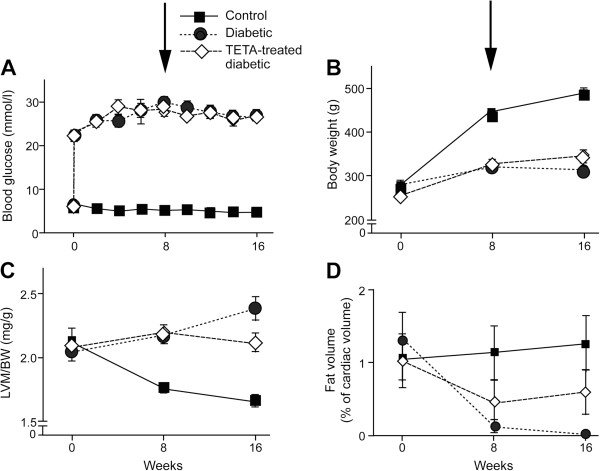
Time- and treatment-dependent changes in blood glucose concentrations, body-weight, and indexes of LV size and composition during the 16-week experimental period in groups of control (n = 12), untreated-diabetic (n = 12) and trientine-treated diabetic (n = 13) adult male rats. Drug treatment was initiated after the measurements of Week 8 (arrowed in A, B). A, Blood glucose concentrations; B, Body-weight; C, Ratio of LV mass to body-weight (LVM/BW); D, Percentage of cardiac fat volume to myocardial volume in the LV. Abbreviation: TETA, triethylenetetramine.